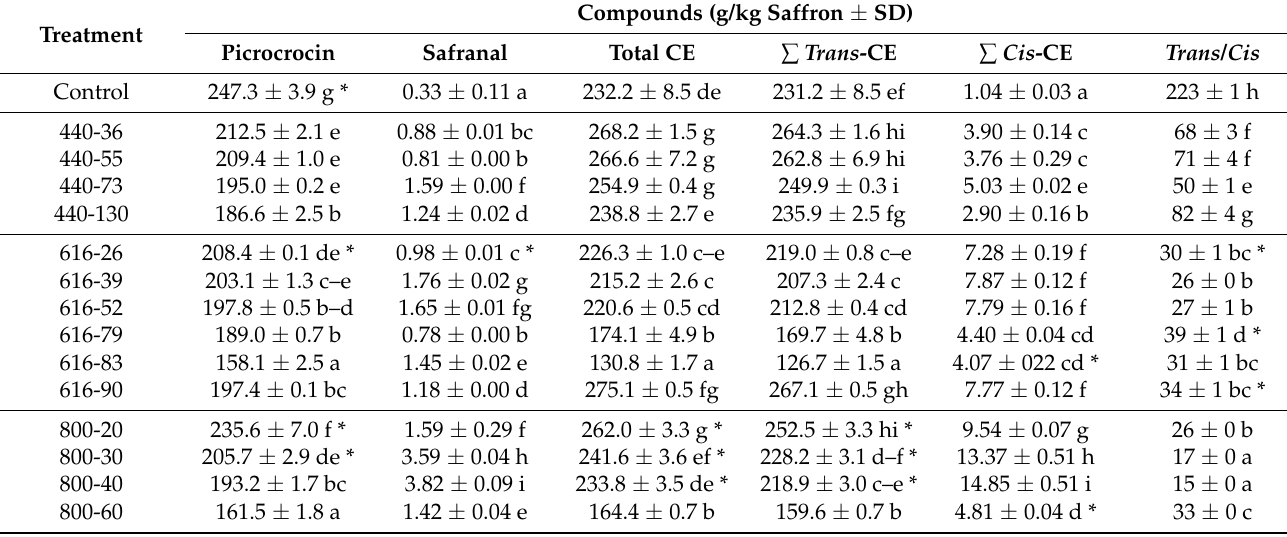
Total CE: Total crocetin esters. ∑ trans -CE: sum of trans isomers of crocetin esters. ∑ cis -CE: sum of cis isomers of crocetin esters. Values are the mean of two extracts conducted in duplicate (2 × 2 n), SD = standard deviation. One-way analysis of variance (ANOVA) for each column is included. Different letters within each column represent statistically significant variances, according to Duncan test ( p < 0.05). Data marked with * does not show significant variances to same treatment and compound before storage ( p <